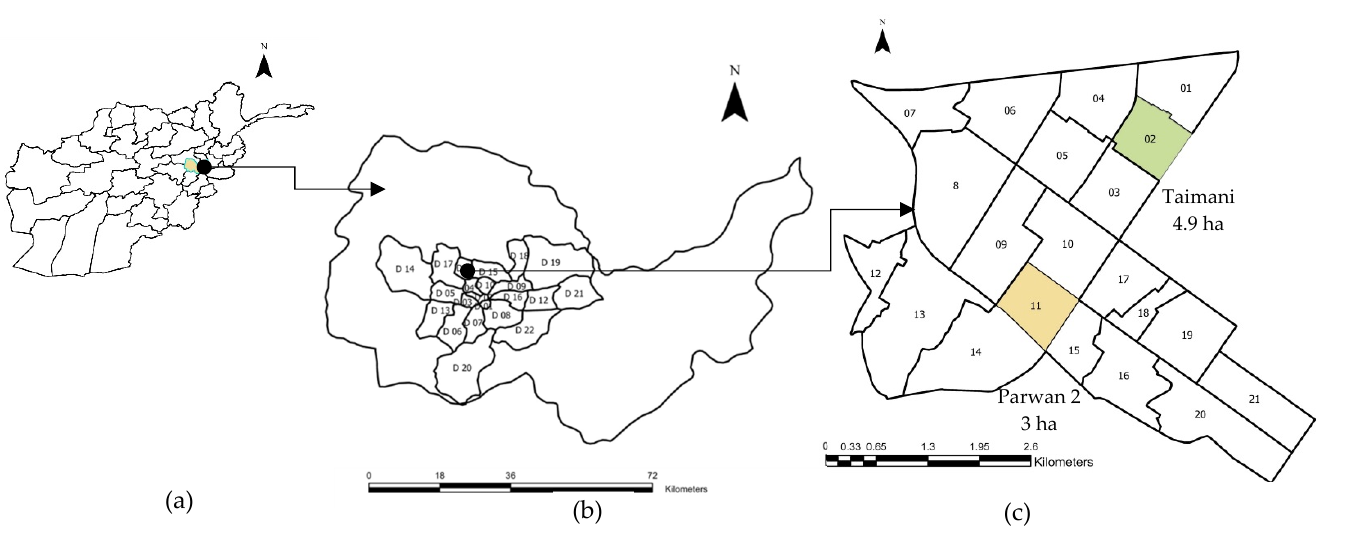
Figure 1. Location of the study area, source: Kabul Municipality; ( a ) Afghanistan and location of Kabul Province; ( b ) Kabul Province and Kabul city; ( c ) District 4: a central district in Kabul city.